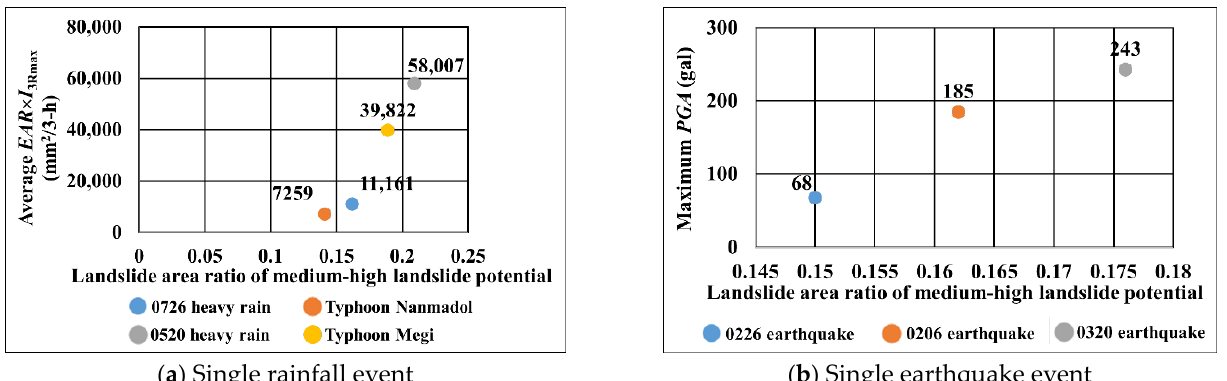
Figure 14. Landslide area ratios of medium–high-level landslides against average EAR × I 3Rmax and maximum PGA induced by a single rainfall or a single earthquake event in Alishan Township.